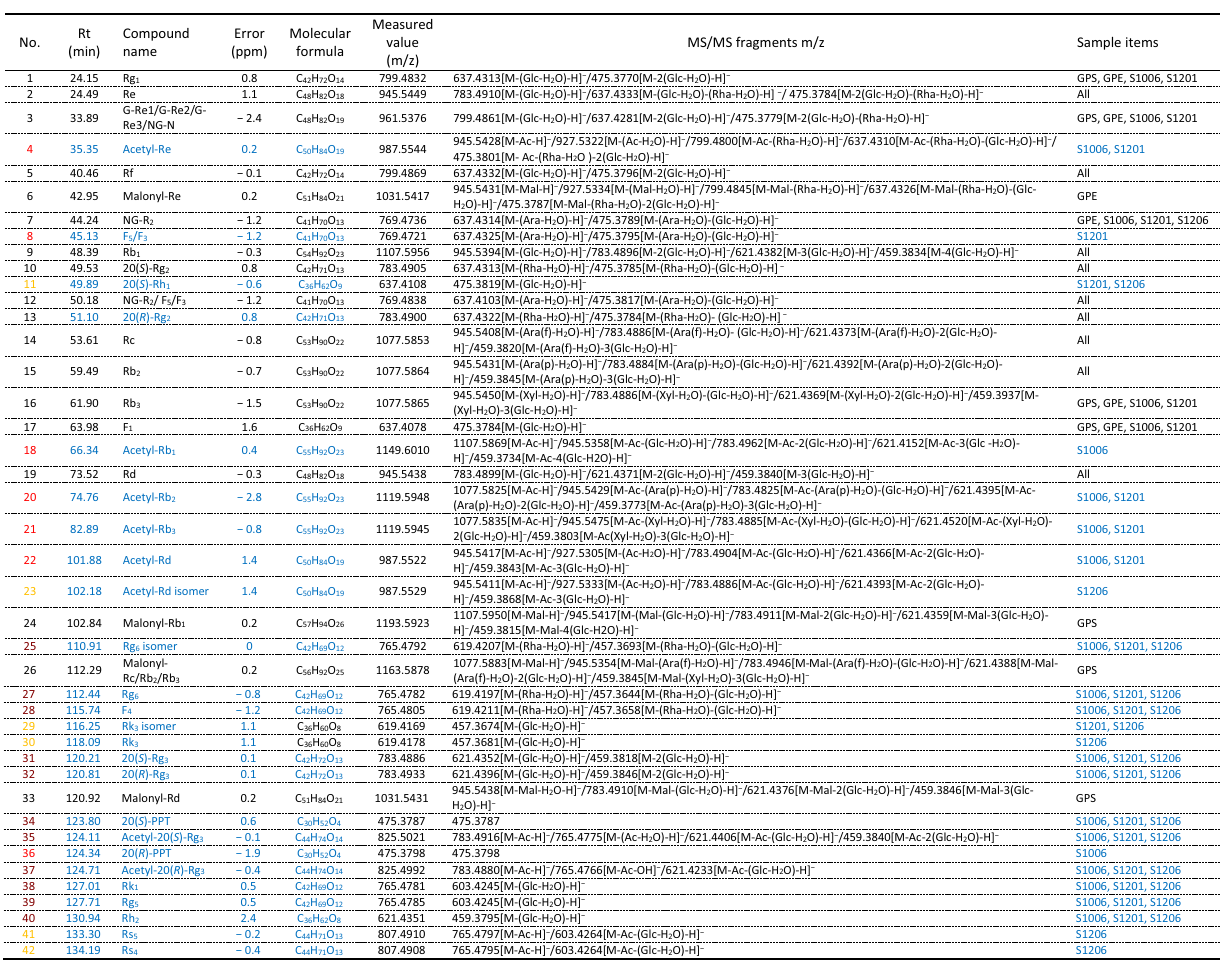
Table 1. Identification of ginsenosides by UPLC-Q-TOF/MS in extracts from unsteamed and steamed ginseng pulps. (i.e. Ara(f), α-L-arabinofuranose (150 Da); Ara(p), α-l-arabinopyranose (150 Da); Glc, β-d- glucopyranose (180 Da); Xyl, β-l-xylopyranose (150 Da); Rha, α-l-rhamnopyranose (164 Da); Mal, malonyl moiety (86 Da); Ac, acetyl moiety (42 Da). a. further confirmed in comparison with authentic standards. b. reported for the first time in steamed pulps.) Data colored in black represent ginsenosides originally existed in extracts from fresh ginseng pulps (GPS and GPE), and those in blue represent ginsenosides newly generated in steamed extracts from ginseng pulps. Numbers in the most left column colored in yellow represent ginsenosides newly generated in S1201 and/or S1206; those in brown, ginsenosides, newly generated in both S1006, S1201 and S1206; those in red, ginsenosides newly occurred in S1006 or S1201 but disappeared during high temperature and long period (S1206); and those in black, ginsenosides originally existed in GPS and/or GPE. GPS, extract from ginseng pulp supernatant; GPE, ginseng pulp extract; S1006, S1201 and S1206, steaming ginseng pulps at 100 °C for 1 h, at 120 °C for 1 h and 6 h,